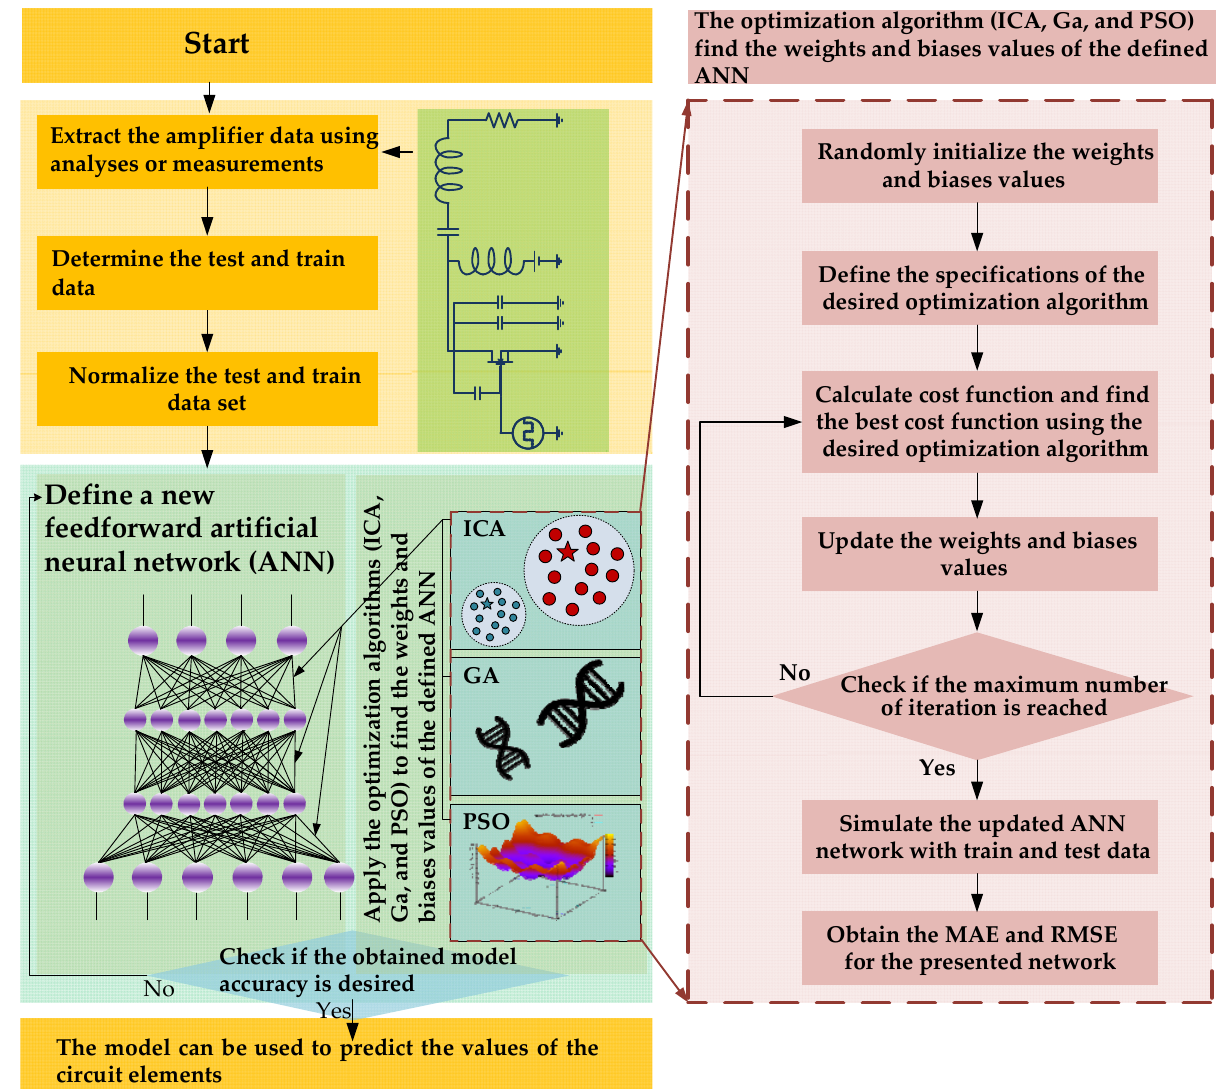
Figure 5. Flow diagram of the presented ANN ‐ optimization algorithm model.